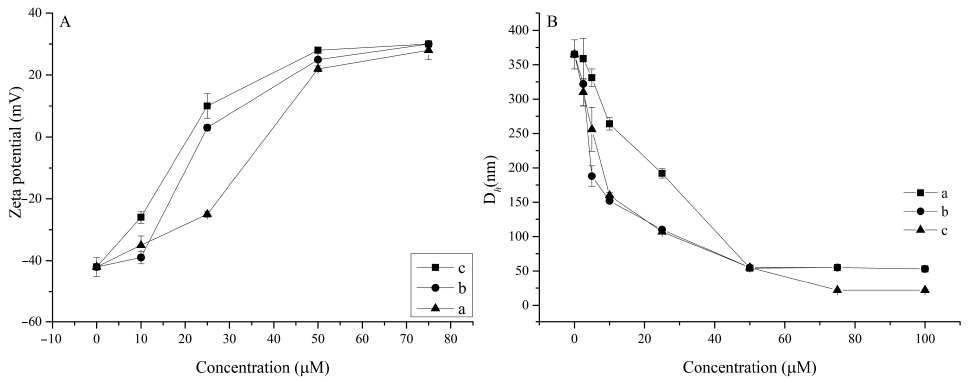
Figure 6. Zeta potential ( A ) and particle size ( B ) of CT-DNA in the presence of different amounts of macrocycles 5 a, 6 b and 7 c. [DNA] = 50 µ